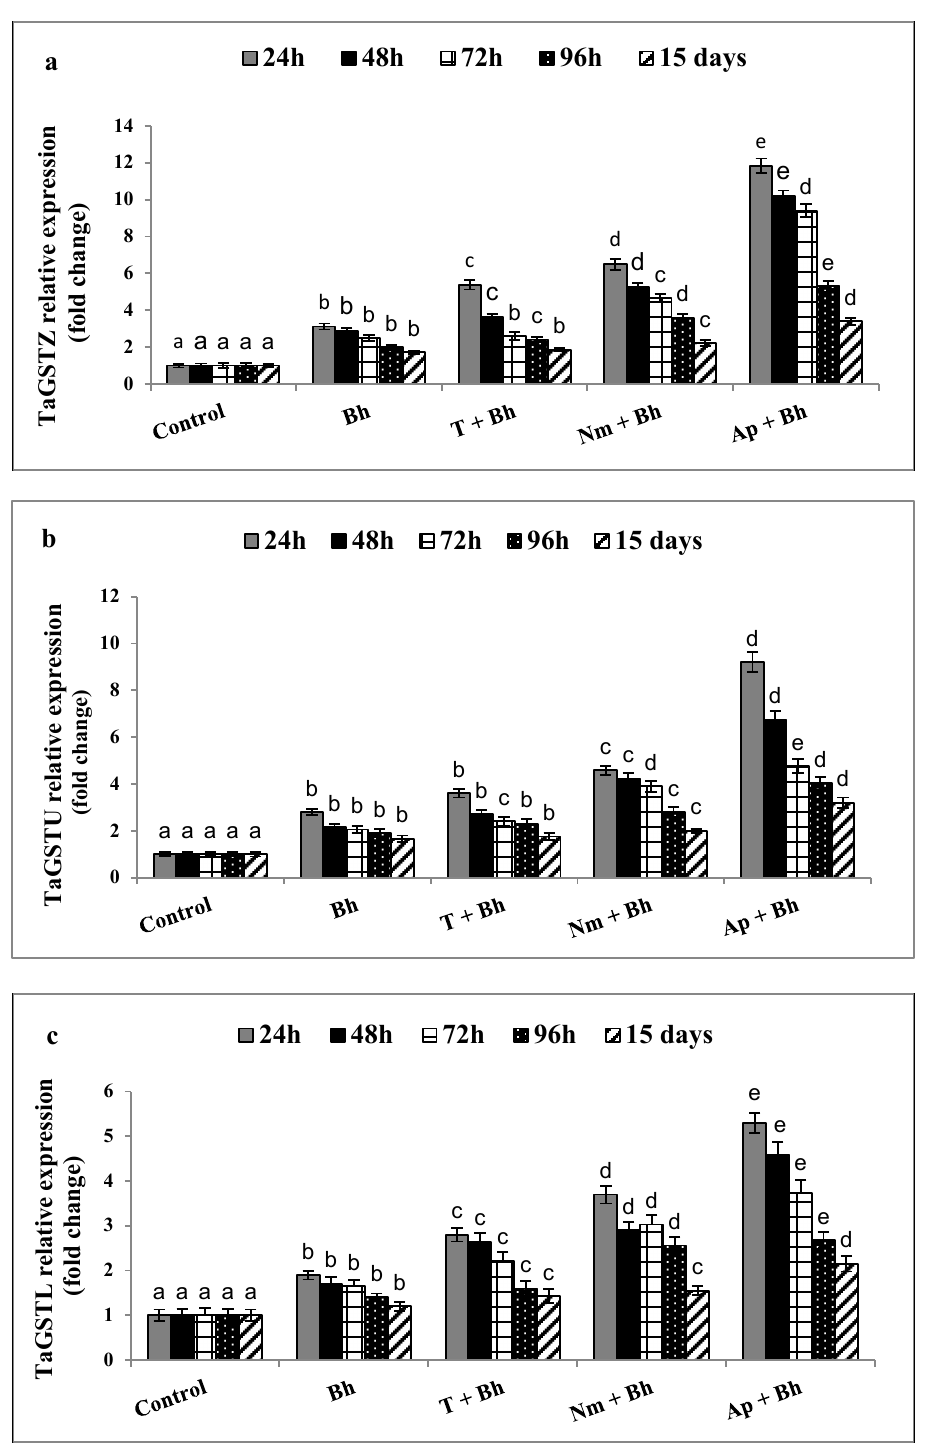
Figure 4. Relative expression of wheat antioxidant-related genes: ( a ) TaGSTZ , ( b ) TaGPTU , and ( c ) TaGSTL after treatment with bromoxynil alone or in combination with different safener treatments. The GABDH gene was used as the housekeeping gene. Data are presented as the mean ± SD ( n = 3). Bh: bromoxynil; T + Bh: tryptophan + bromoxynil; Nm + Bh: Nostoc muscorum + bromoxynil; Ap + Bh: Arthrospia platensis + bromoxynil. Different letters on the bars indicated a significant difference between treatments at p < 0.05.